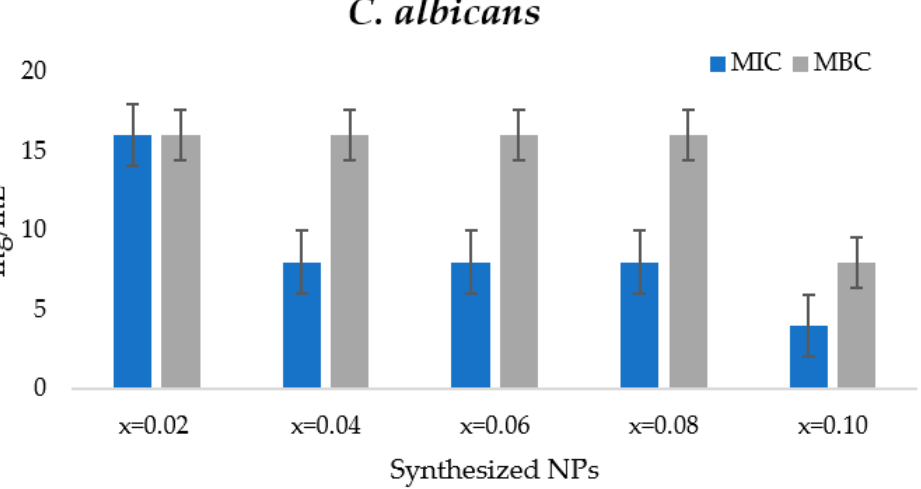
Figure 6. MIC and MFC of ultrasonicated Mn 0.5 Zn 0.5 Er x Y x Fe 2 − 2x O 4 NPs against C. albicans survival .